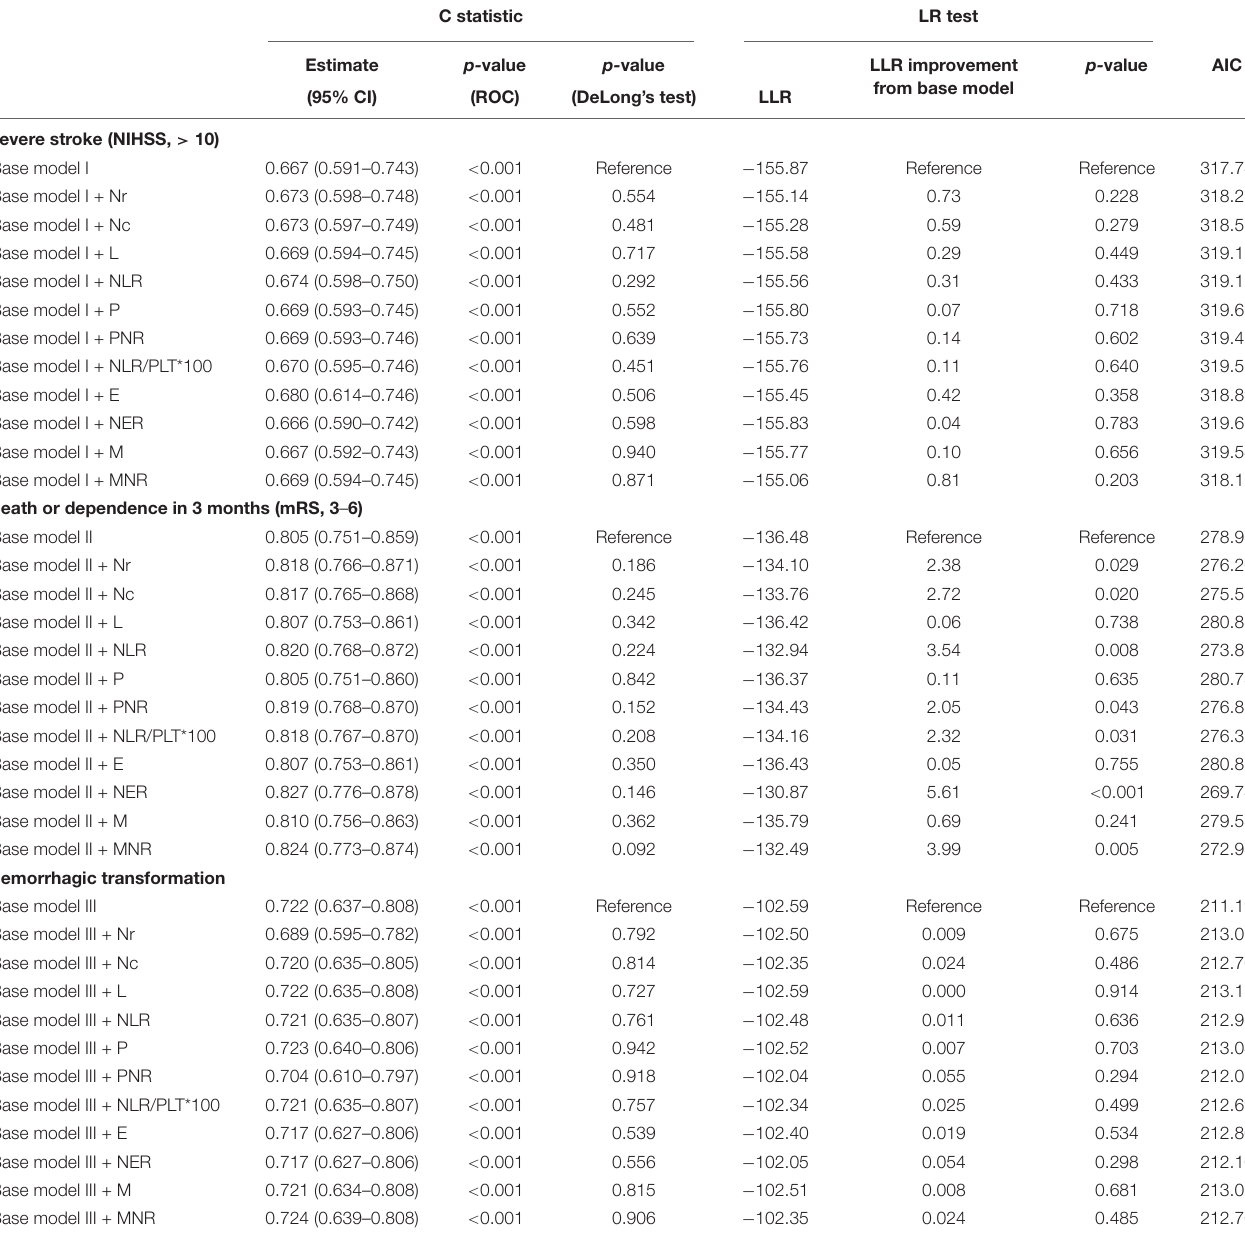
TABLE 4 | Diagnostic values of the base models and when the neutrophils-related ratios are added for the severity of stroke on admission, stroke outcome at 3 months, and hemorrhagic transformation. C